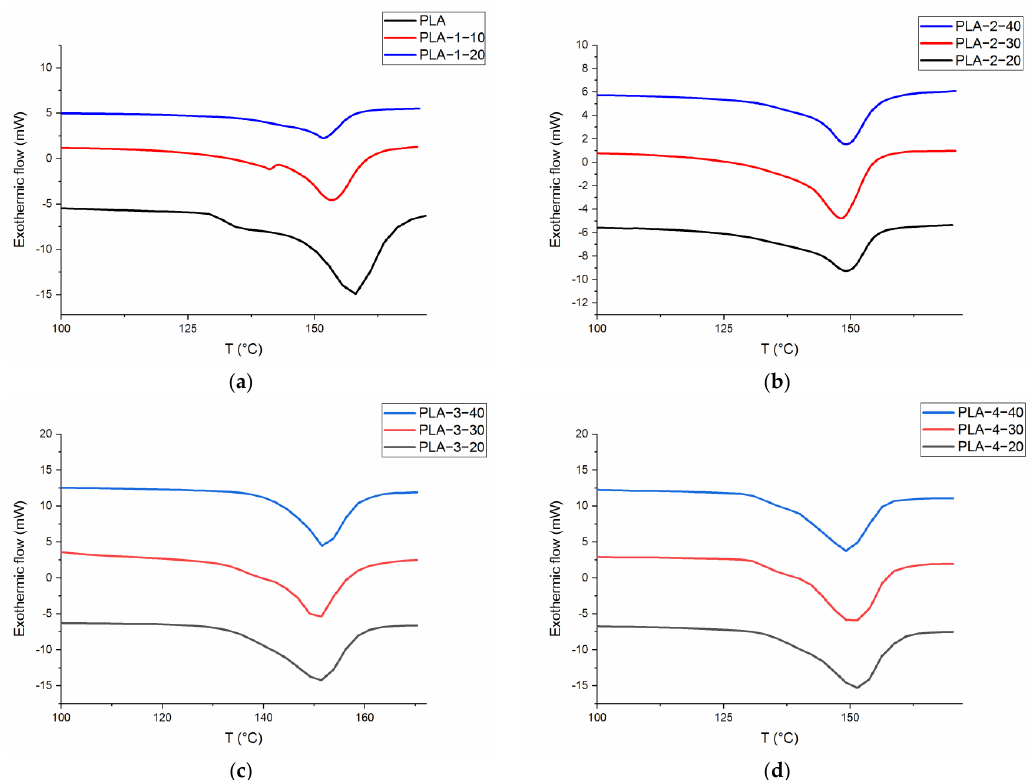
Figure A2. DSC profiles corresponding to the temperature regions with the PLA melting during the first heating run ( a ) for pristine PLA and mixtures PLA − 1 − 10 and PLA − 1 − 20 with 10 and 20% w/w of cutin monomer 1 in the blending with PLA; and ( b – d ) for mixtures PLA − X − Y where X stands for the molecule ( 2 – 4 ) employed and Y for its concentration in the blending with PLA.